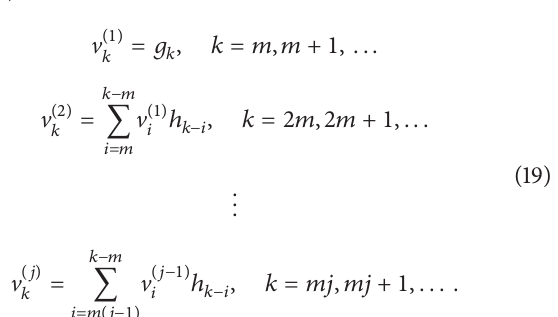
Figure 2: The availability curve under model B with 𝜏 = 1.0 , 𝑏 = 0.1 , 𝑐 = 0.2 , and 𝑚 = 3 .